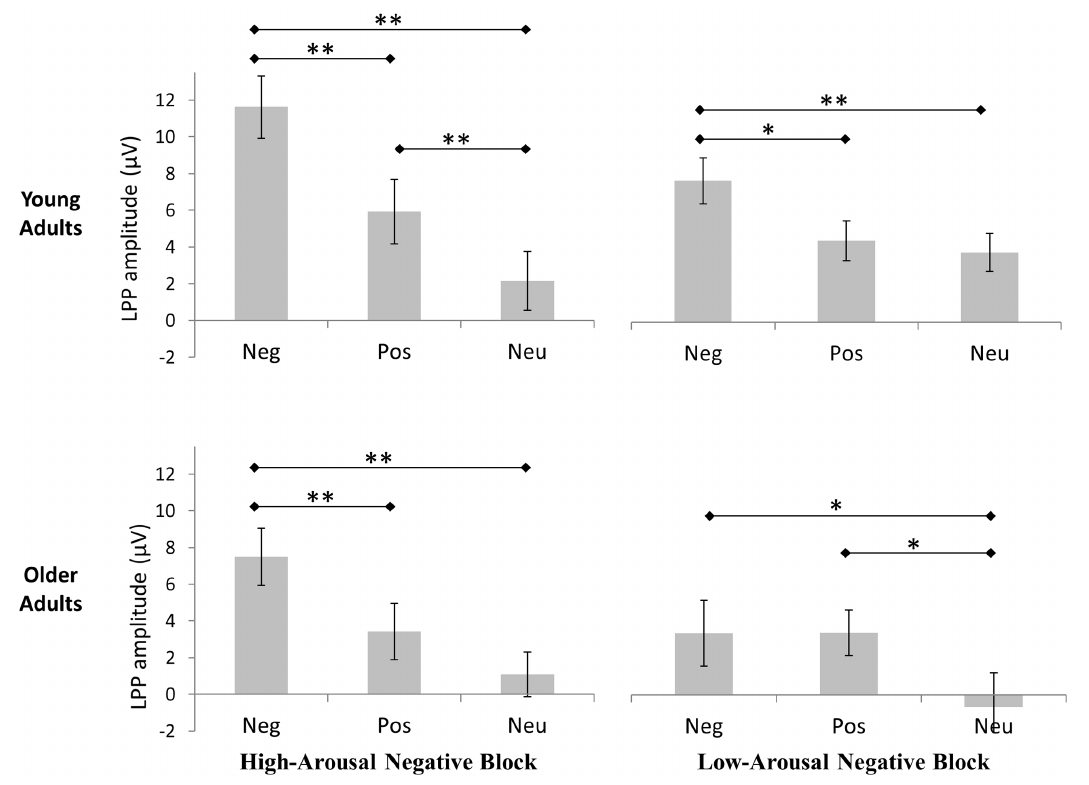
Figure 2. Mean amplitude of the LPP for the different experimental conditions in each age group. Significant post-hoc comparisons are represented by asterisks. ** 0.01 significant threshold, * 0.001 significant threshold .